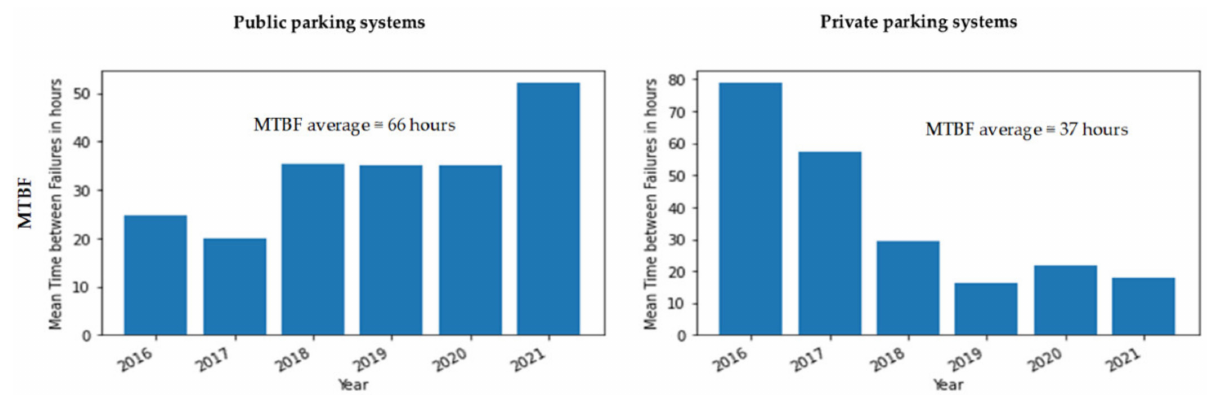
Figure 11. Mean Time between Failures (MTBF) in hours for all failures for public ( left ) and private ( right ) parking